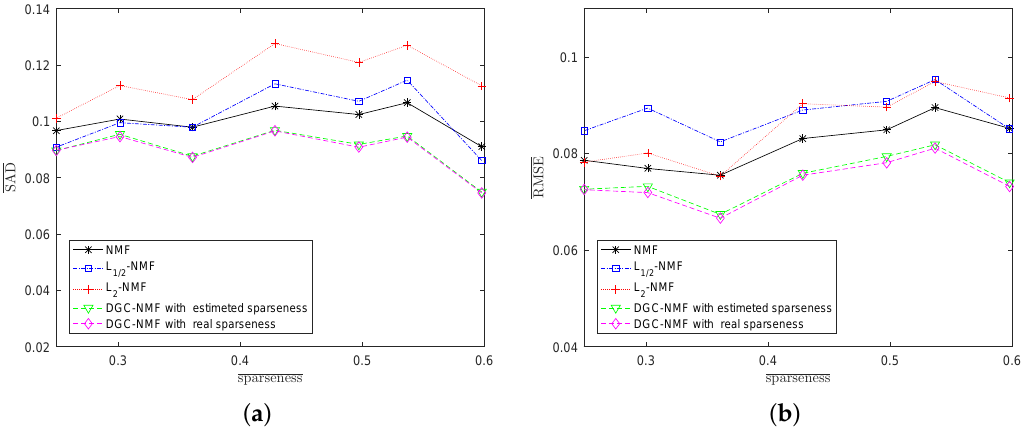
Figure 7. Performance comparison of the algorithms when sparseness level of abundance varies. ( a ) spectral angle distance (SAD); ( b ) root-mean-square error (RMSE).